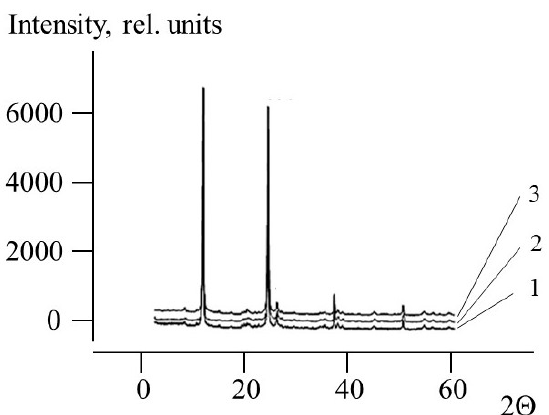
Figure 4. X-ray diffraction patterns of kaolinite (1), kaolinite–PHum (2), and kaolinite–PDADMAC dry samples (3).